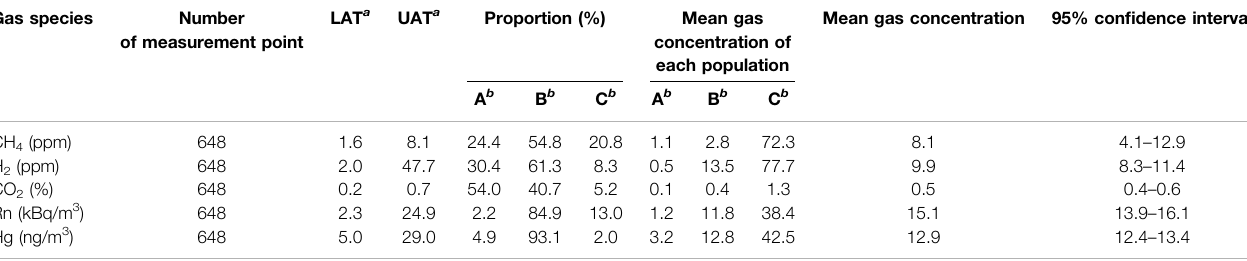
TABLE 2 | Threshold values, proportions, mean concentration of each population, and 95% con fi dence interval of soil gases in the XXFS obtained by statistical approach. Gas species Number of measurement